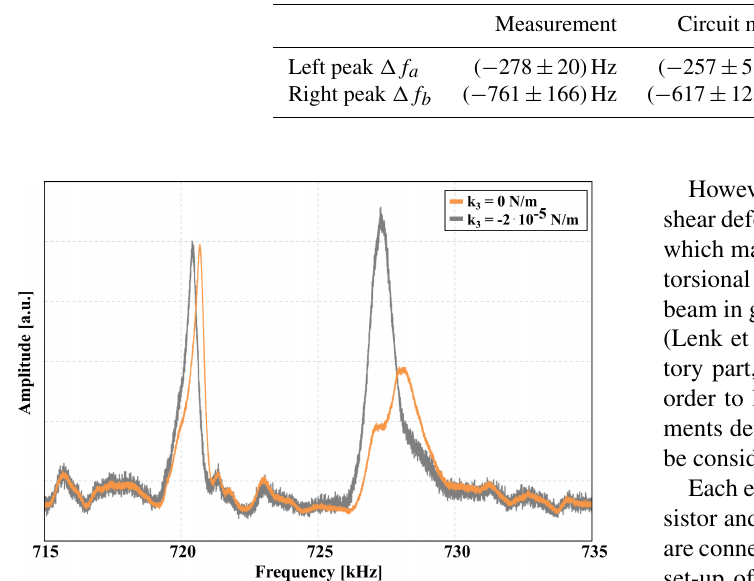
Table 6. Comparison of analytically derived and measured frequency shift values for an external interaction of k 3 ≈ ( − 2 ± 0 . 5) × 10 − 5 Nm − 1 .